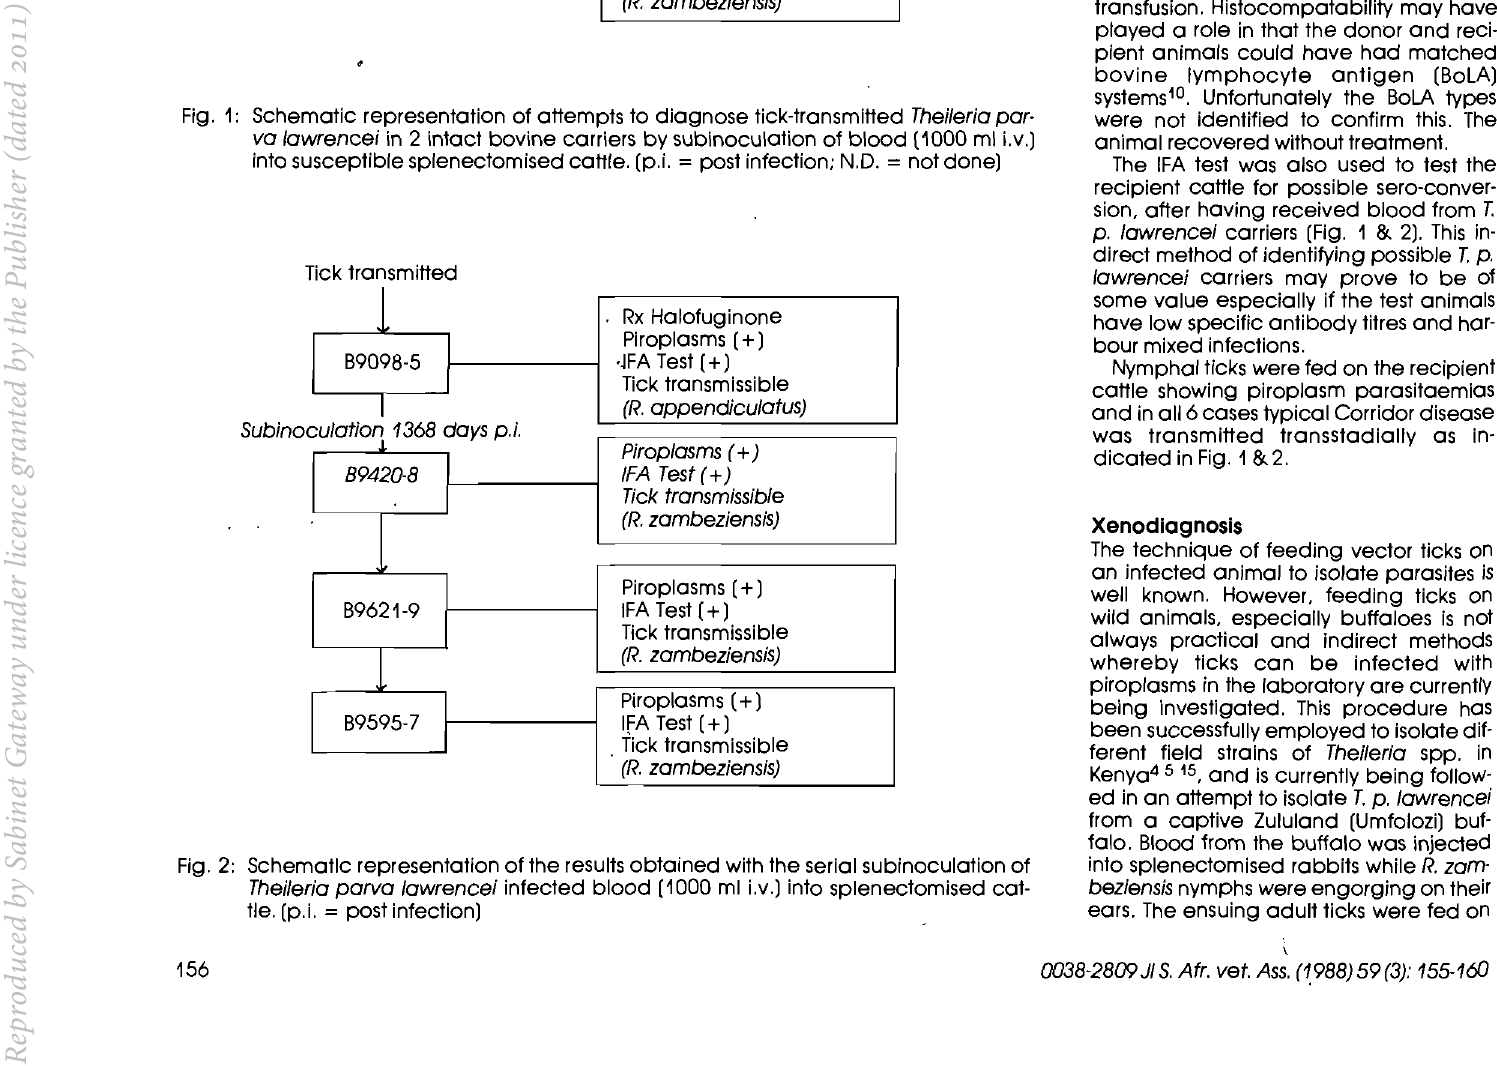
Fig. 1: Schematic representation of attempts to diagnose tick-transmitted Theileria par va lawrencei in 2 intact bovine carriers by subinoculation of blood (1000 ml i.v.) into susceptible splenectomised cattle. (p.i. = post infection; N.D. = not done)